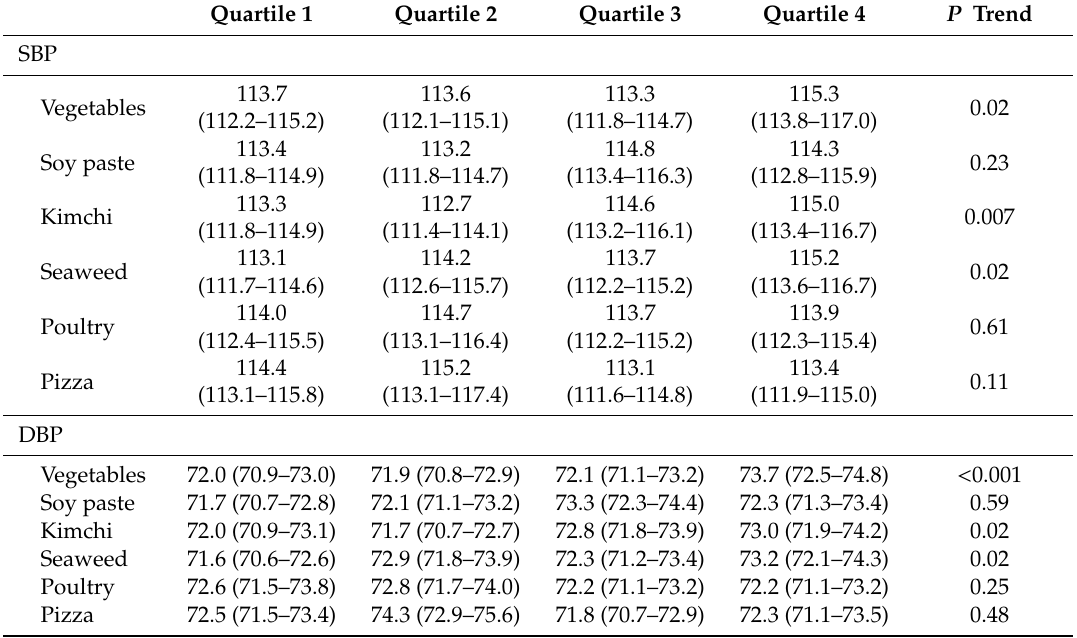
Table 6. Multivariate-adjusted geometric means (95% CIs) 1 of systolic and diastolic blood pressure according to each food group with a high sodium contributing food